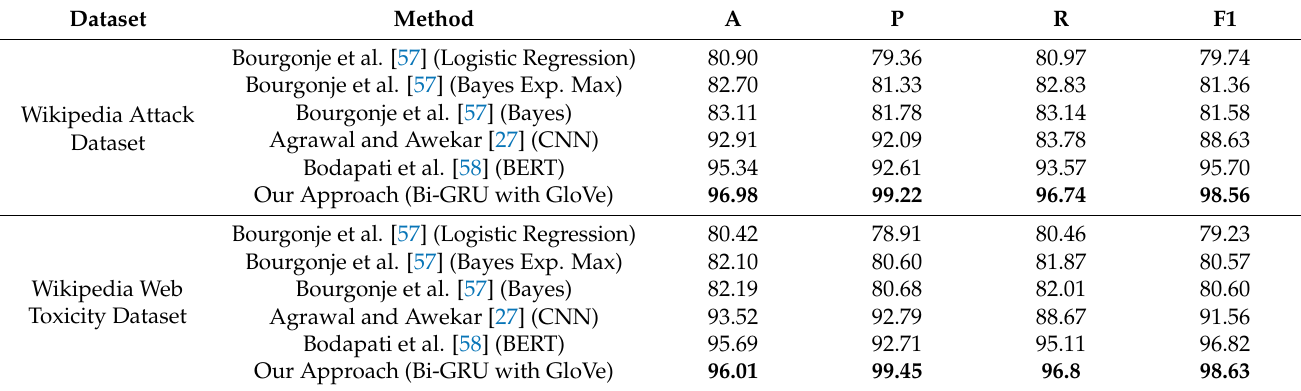
Table 3. Baseline comparison on Wikipedia Attack and Wikipedia Web Toxicity datasets.